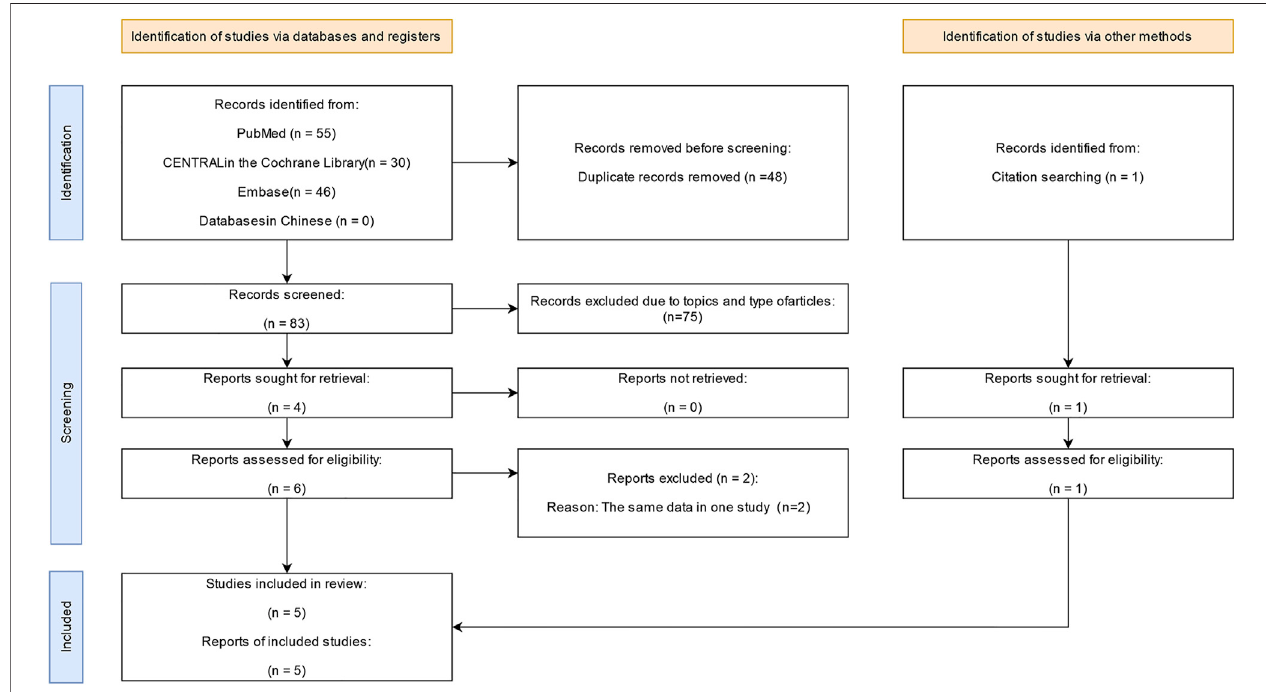
FIGURE 1 | Flow diagram of the screening